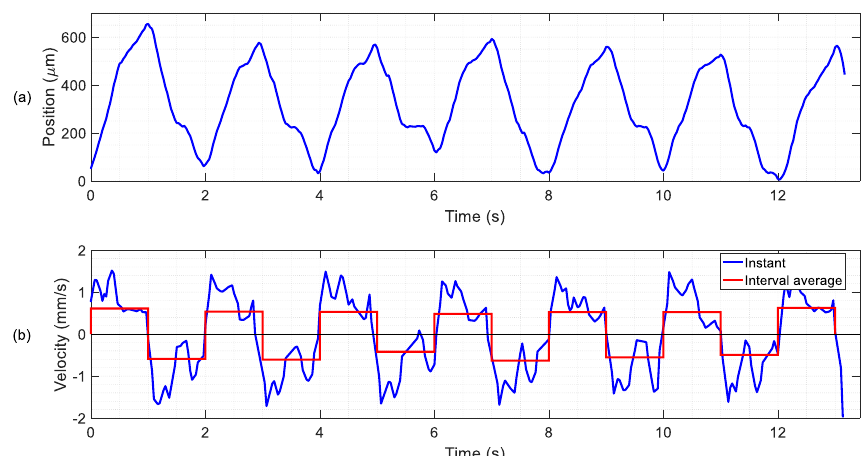
Figure 8. Measured results for the 3 mg slider on the LF device with 4 legs. ( a ) Slider position and ( b ) deduced velocities during the experiment with 2 V excitation signals at 19.3 kHz. The phase difference between the signals of the patches was alternated between 90° and −90° every second.